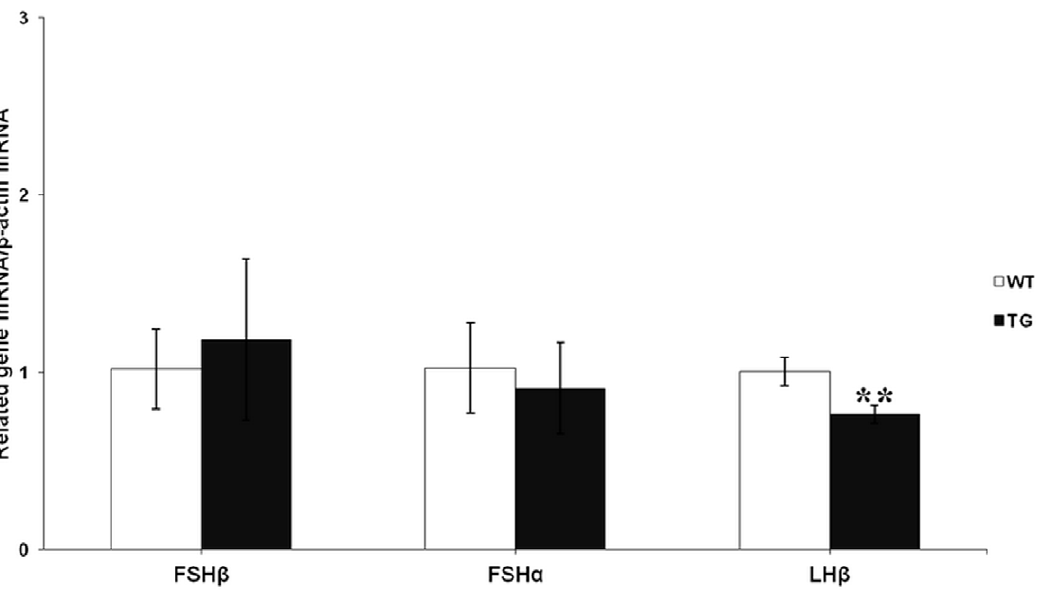
Figure 8. Pituitary FSH a , FSH b and LH b mRNA expression in TG and WT mice. Mouse FSH a , FSH b and LH b mRNA were analyzed using quantitative real-time PCR with specific primers and were expressed relative to a b -actin (internal control) ( n =7–8 mice per genotype). Data were combined from three independent experiments; bars represent means 6 SEM; ** P , 0.01. The results of the analysis of each of the two separate lines were found to be comparable to that of the combined analysis.